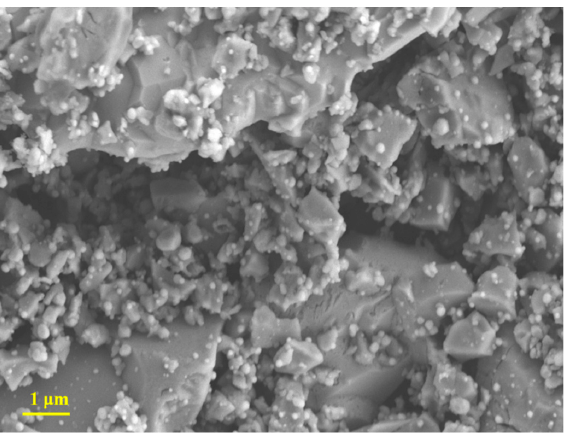
Figure 3. SEM image of Pd infiltrated Ag-LSCF anode surface before testing.